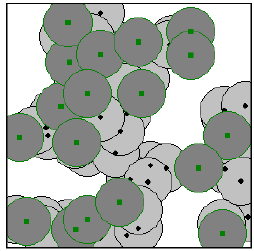
Figure 4. Initial deployment of the mobile sensor nodes.